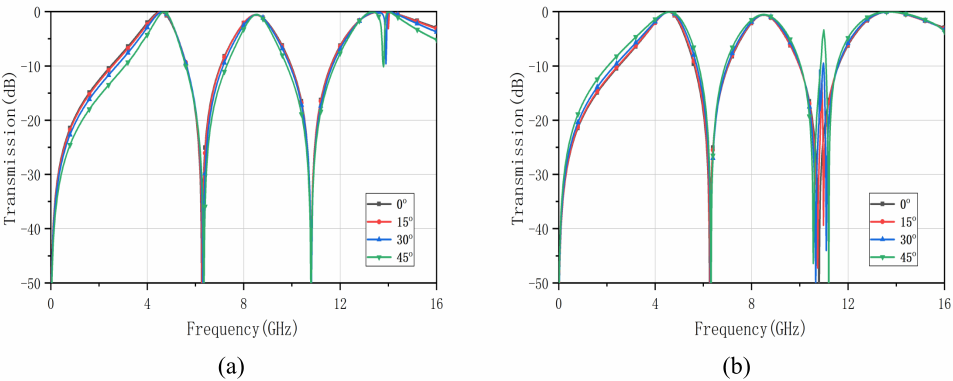
Figure 8. Transmission coefficients under different oblique incidence angles of the optimized triple band − pass FSS. ( a ) TE polarization, ( b ) TM